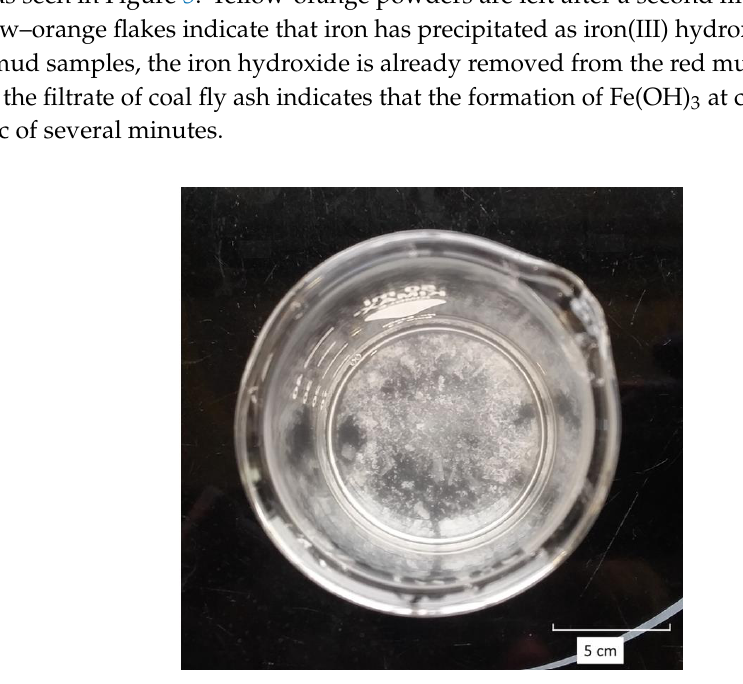
Figure 5. Suspension in the 5, 10 and 20 min samples after treatment with coal fly ash. The XRF analysis showed that the yellow powder after treatment with coal fly ash, filtration and drying mainly contains approximately